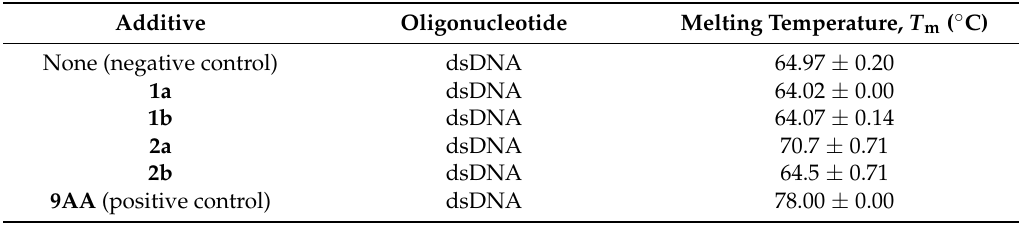
Table 2. Influence of examined compounds on the thermal stability of